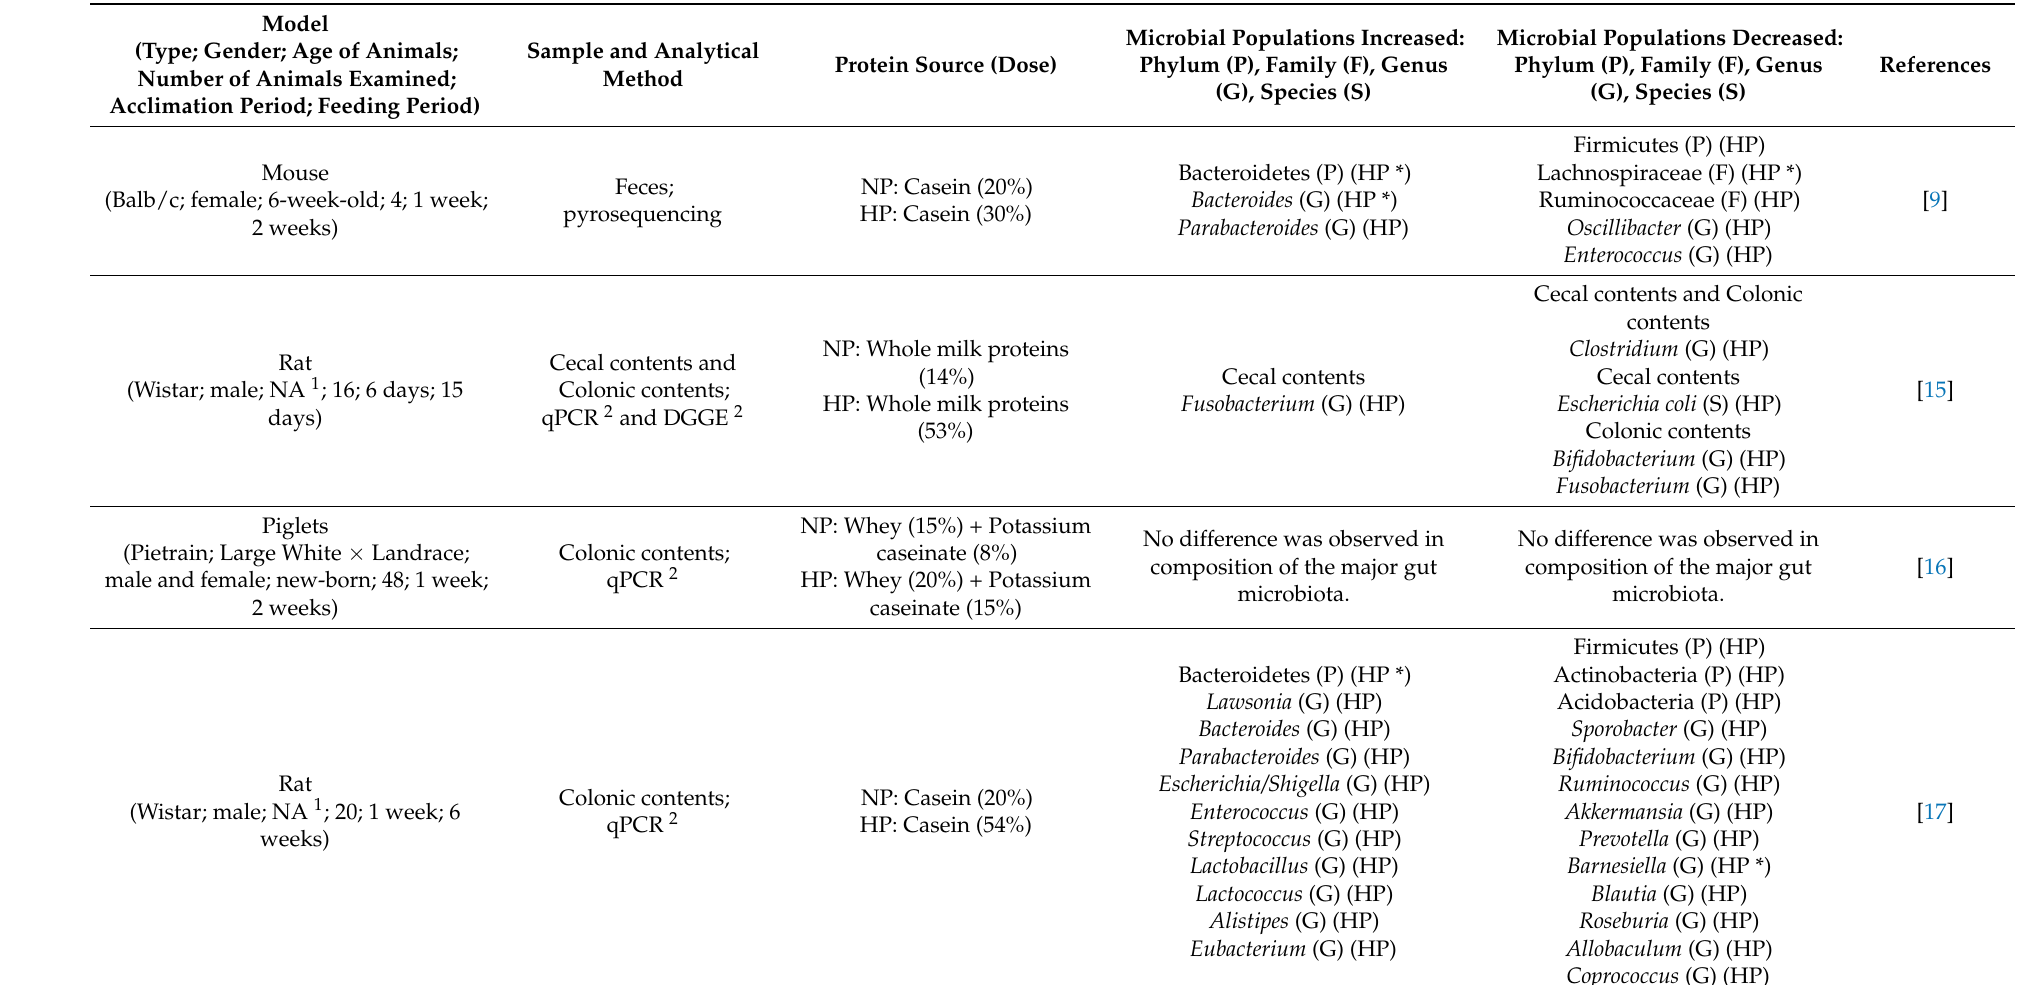
Table 1. The impact of dietary protein on gut microbiota, expressed as relative abundance (% of total